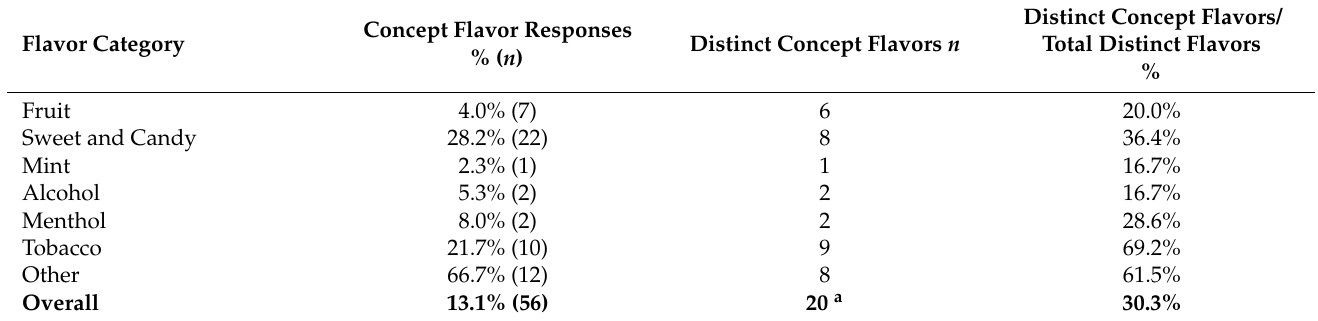
Table 3. Concept flavor responses in flavor categories.